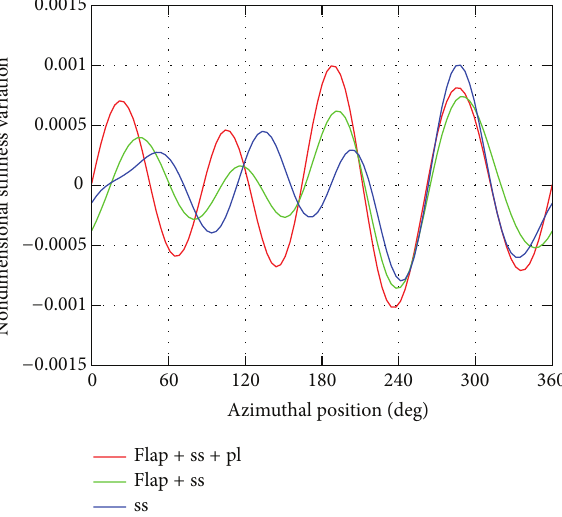
Figure 10: Hub loads with feedback, prescribed-wake synthesis, and free-wake inflow validation.